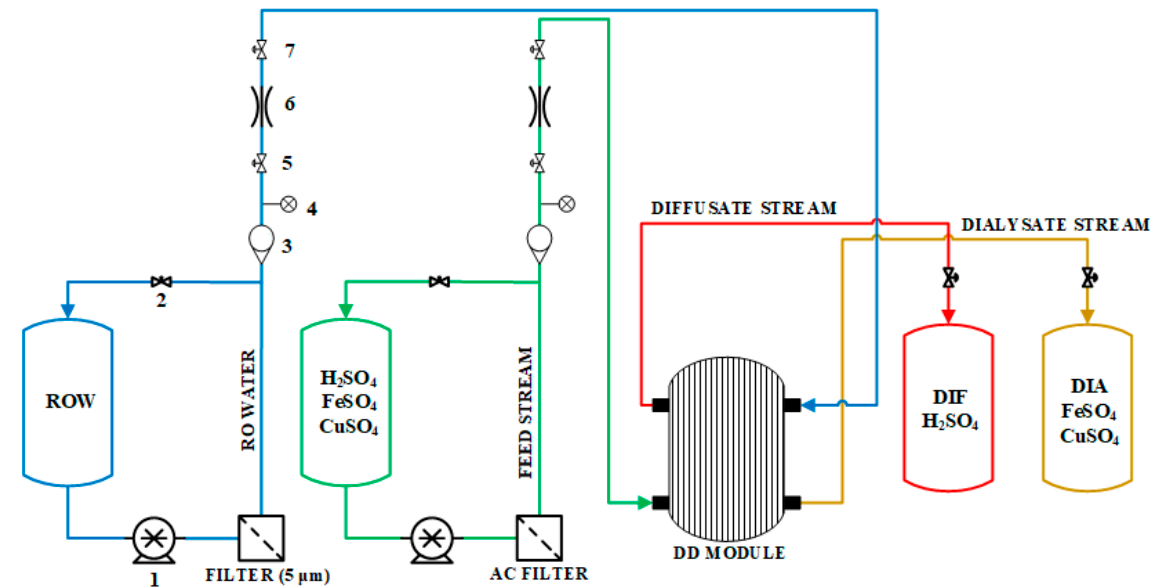
Figure 7. Simplified process flow diagram of the acid-recovery system. Instrumentation key: (1) pump; (2) needle valve; (3) rotameter; (4) pressure sensor; (5) manual valve; (6) flow control valve; (7) manual valve.